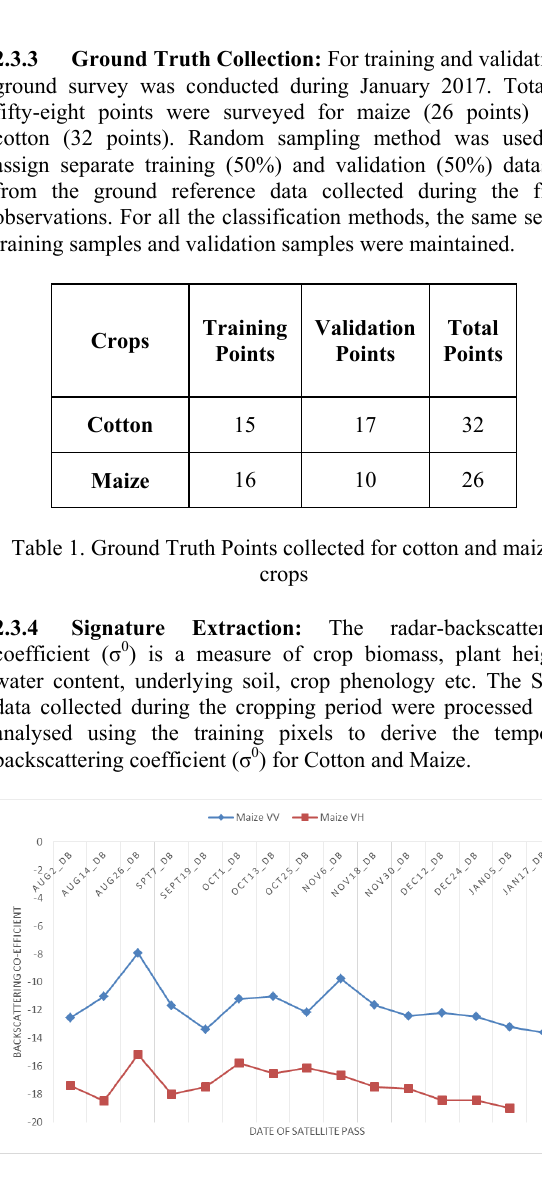
Figure 3. Mean temporal back scattering of Maize